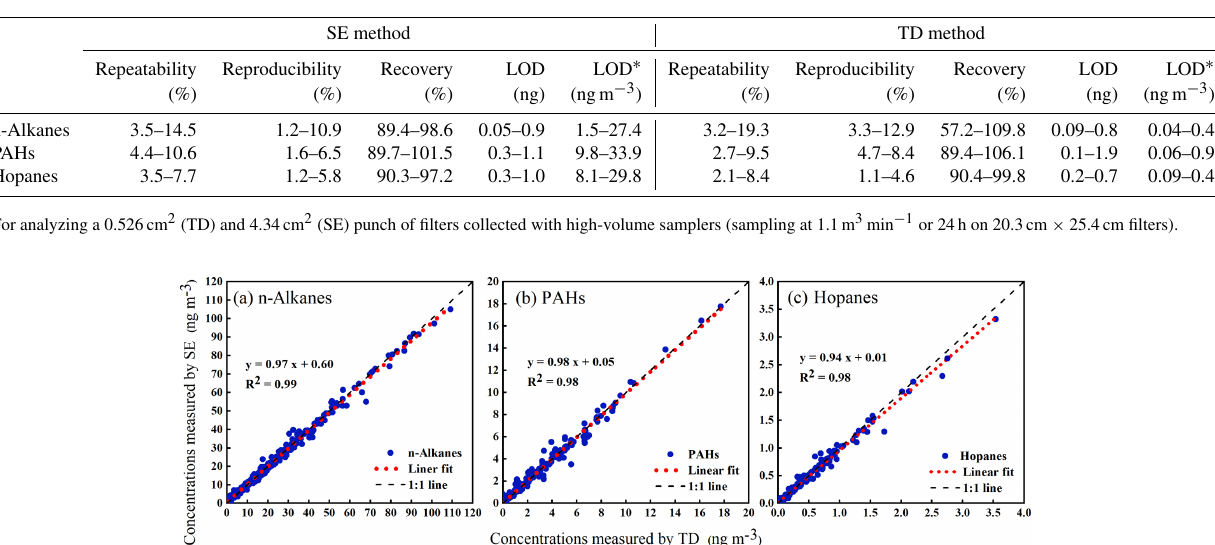
Table 1. Analytical performance of SE-GC-MS and TD-GC-MS methods for determination of n-alkanes, PAHs and hopanes.